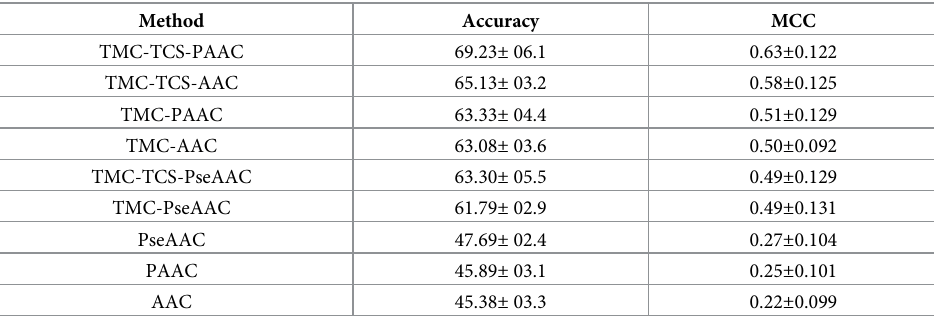
Table 2. Overall cross-validation performance of the